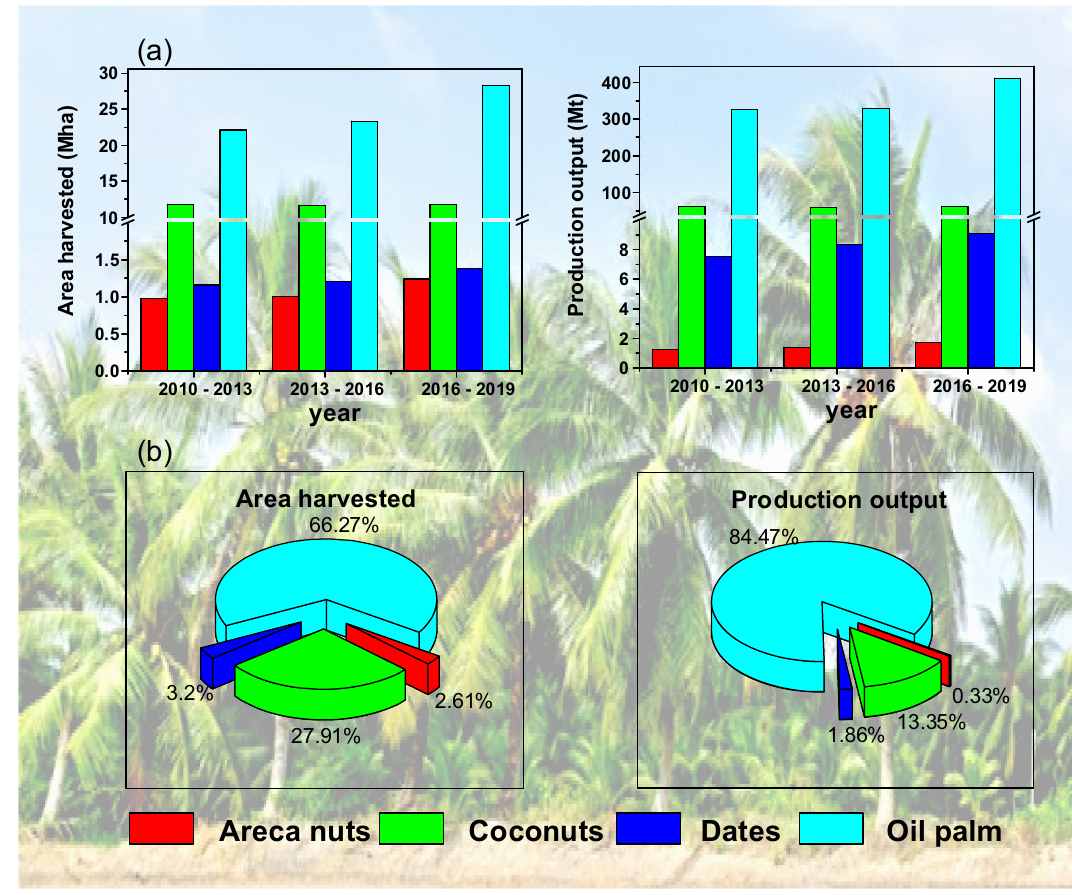
Figure 1: ( a ) Cultivated area and production yield and ( b ) percentage of production and area of Arecaceae 2019, data sources are